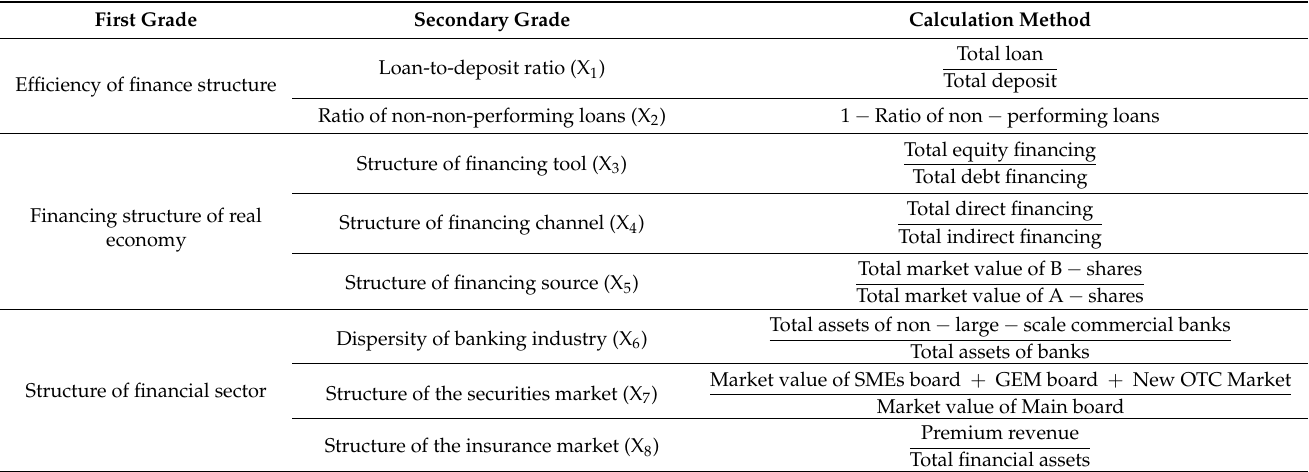
Table 1. Finance structure index system of